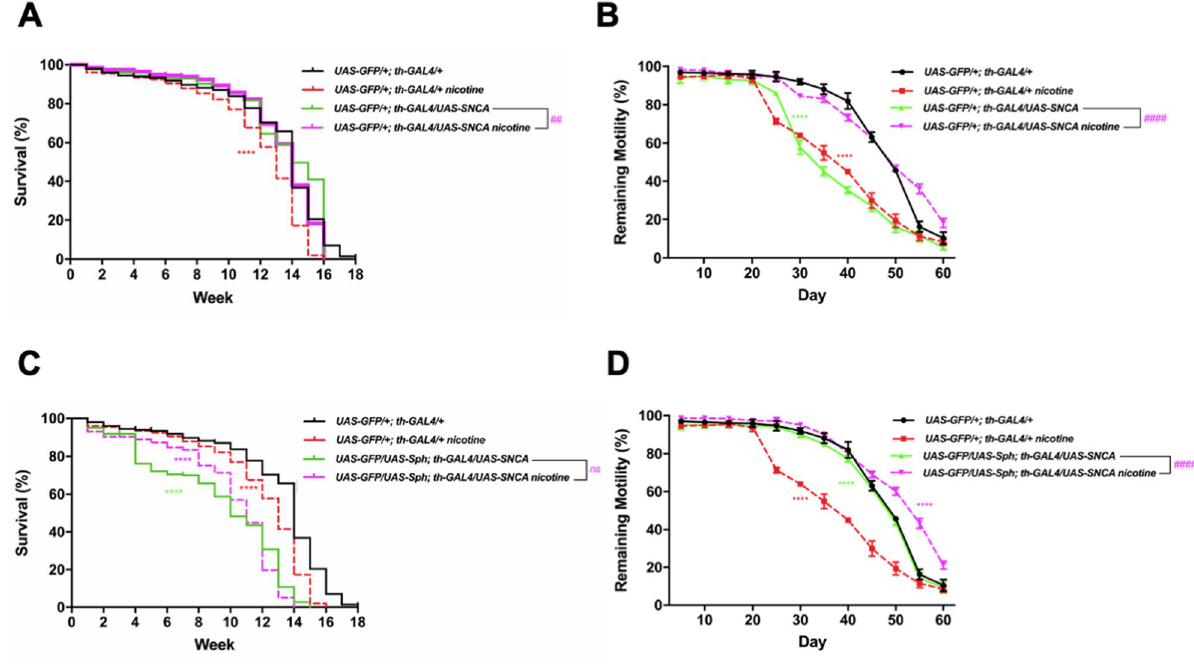
Figure 2. Nicotine treatment increases motility in α-synuclein (SNCA) expressing flies, while reduces it in control animals. ( A ) Lifespan and motility in control animals (that do not express SNCA) are reduced when treated with 24 µM nicotine. Flies expressing SNCA in dopaminergic neurons have a significantly reduced life expectancy which is similar in chronic nicotine treated animals (24 µM). ( B ) However, motility is rescued in genotypes that are predisposed to PD like symptoms and treated with nicotine. ( C , D ) show the lifespan and motility in animals that co-express Sph-1 and α-Syn. As previously reported 21 , animals that co-express both proteins have a milder phenotype that the ones that only express Sph-1. It has previously been reported that the co-expression of Sph-1 with α-Syn partially suppresses the toxicity caused by the expression of the individual proteins. The flies that co-express Sph-1 and α-Syn have milder phenotypes, and the effect of nicotine is also more subtle. Regardless of the penetrance of the PD like genotype, nicotine always appears to have beneficial therapeutic effects in the organisms that are predisposed to PD like symptoms. Data of untreated control animals are presented with black traces solid lines; data of nicotine-treated control animals are graphed with red traces dotted lines. Statistical analyses were performed using Log-rank (Mantel-Cox) test. Asterisks are used to show statistical significance between the untreated control line ( UAS-GFP/ + ; th-GAL4/ +) and all the other genotypes and conditions, the number symbol (#) is used to show stratistical significance between the treated and untreated SNCA lines ( UAS-GFP/ + ; th-GAL4/UAS-SNCA ) **** or #### P < 0.0001, ### P < 0.001, ns: no aignificative. n = 200 animals per experimental condition. All treated animals were chronically exposed to 24 µM